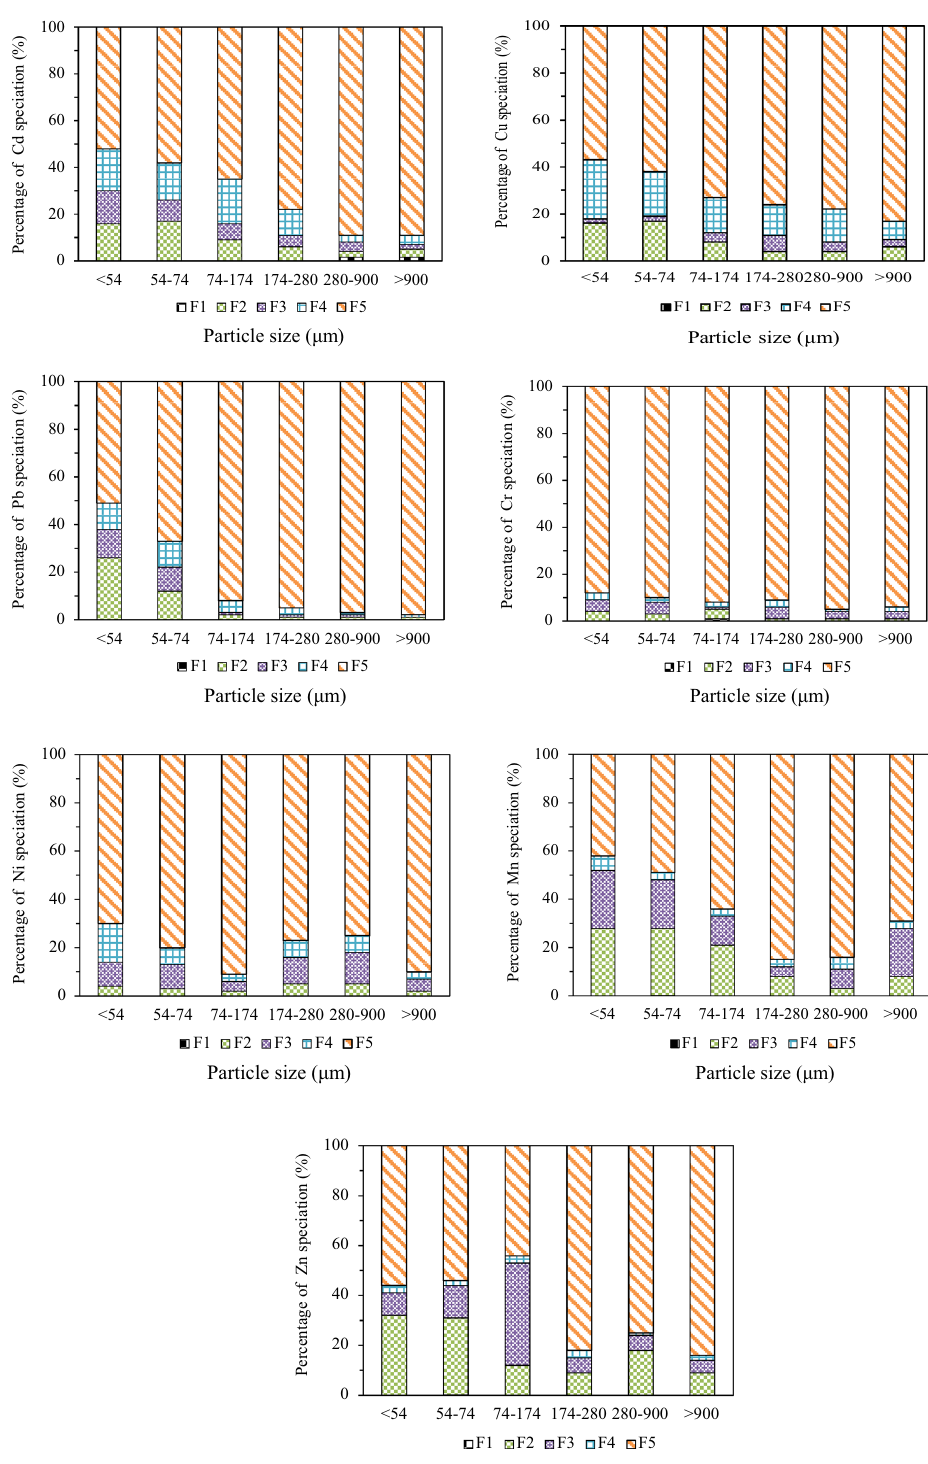
Figure 3. Speciation distribution and percentage of seven heavy metals in fly ash with different particle sizes